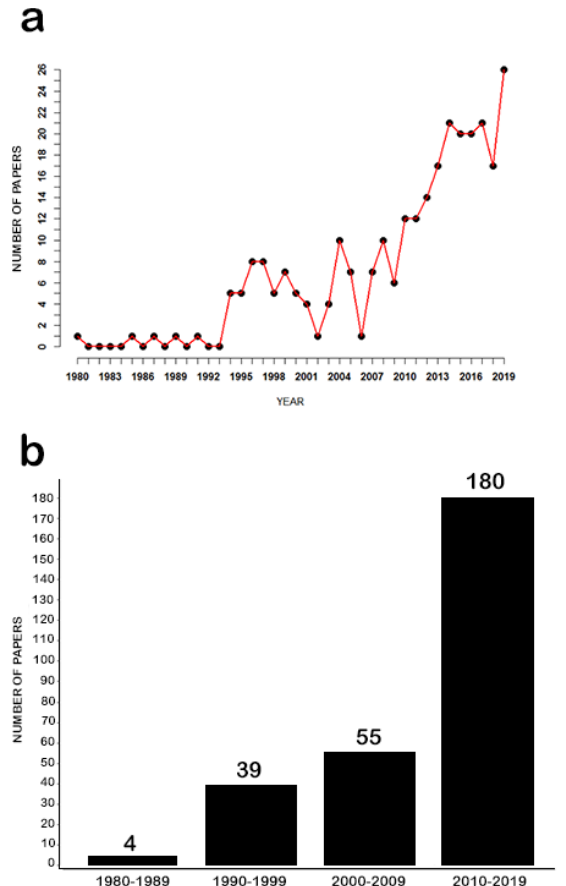
Figure 2. Growth of number of articles published about isotopic studies of Quaternary megafauna fossils. (a) Evolution of quantity of publications per year since 1980, (b) Number of published articles by